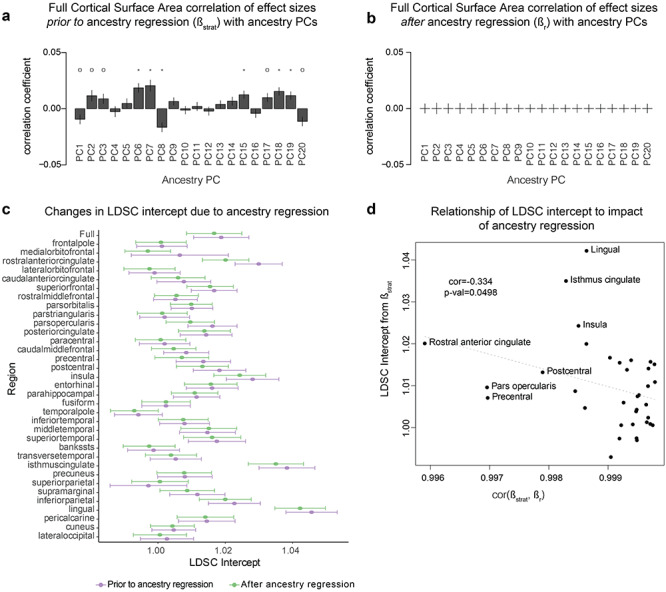
Identifying and correcting for the effects of subtle population stratification on GWAS results. (a) Correlations between SNP loadings on ancestry PCs (Beta_PCs) and GWAS effect sizes for full SA (Beta_Strat) demonstrate evidence for subtle population stratification (* indicates Bonferroni corrected significant correlation P-value < 0.0025, and o indicates a nominally significant correlation, P-value < 0.05). (b) Subtle population stratification is reduced after ancestry regression. (c) LD-score regression (LDSC) intercepts, standard measures of population stratification, are generally decreased after ancestry regression. An absence of population stratification and cryptic relatedness would be indicated by an LDSC intercept value of 1. (d) There is an inverse relationship between the degree of subtle population stratification (LDSC intercept prior to ancestry regression) and the amount of change caused by ancestry regression (cor[Beta_strat, Beta_r]). Error bars represent standard errors.